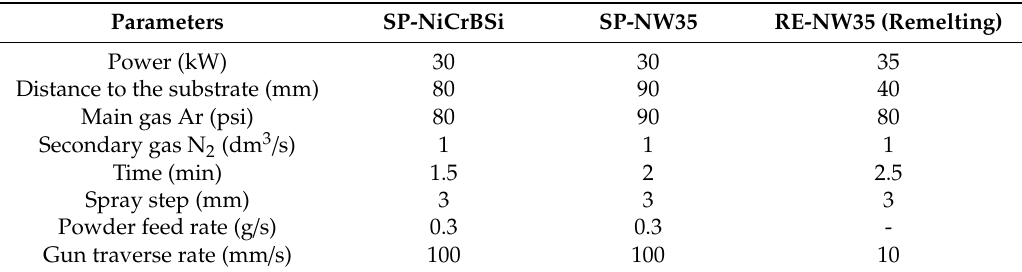
Table 2. Plasma Spraying and Remelting